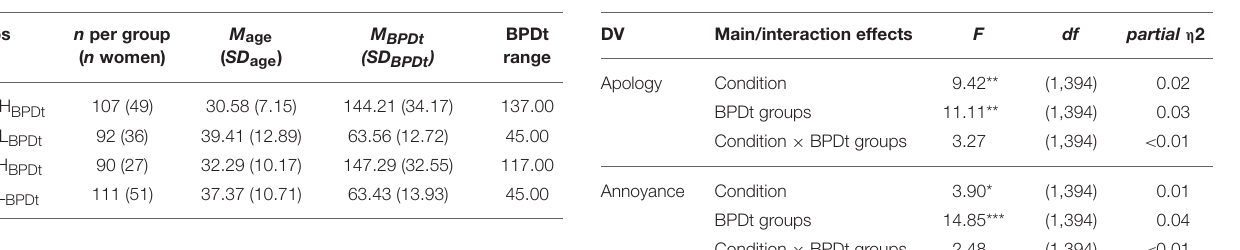
TABLE 4 | Analyses for experiment